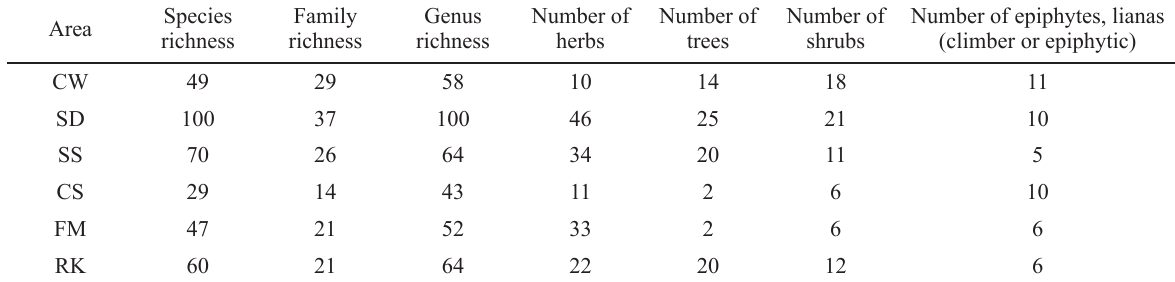
Richness of species, families and genera, and number of species per habit in the six studied areas along the